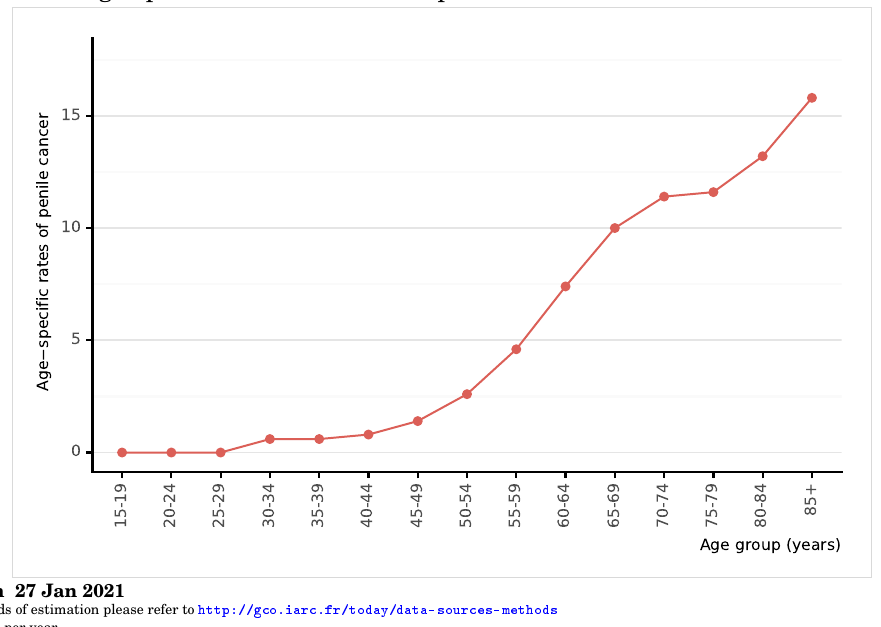
Figure 31: Age-specific incidence rates of penile cancer in India (estimates for 2020)